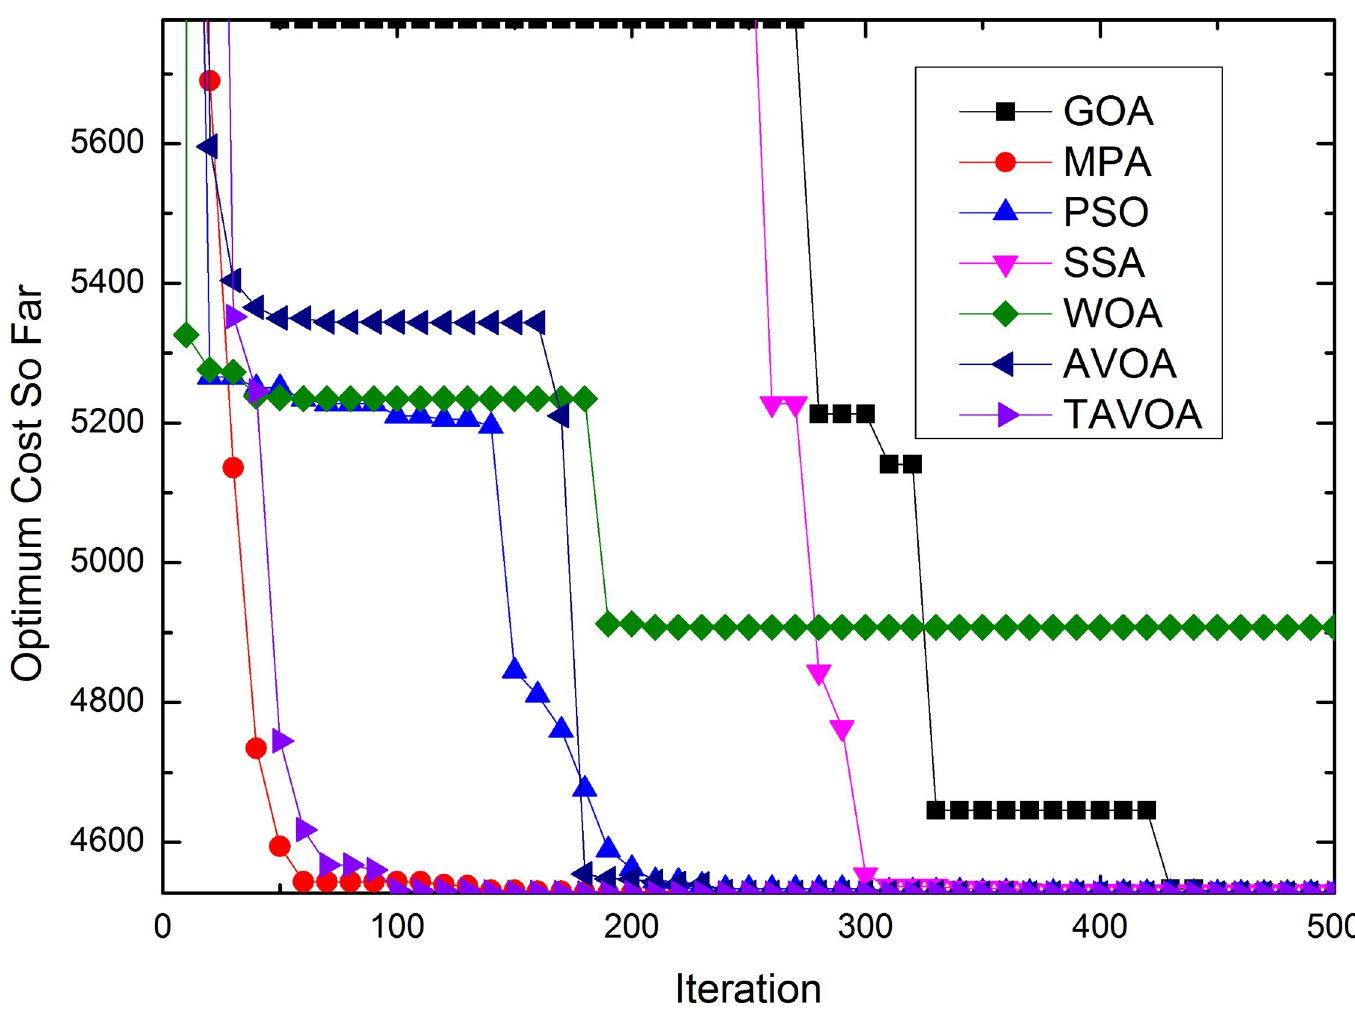
Fig 19. Convergence process in the pressure vessel design